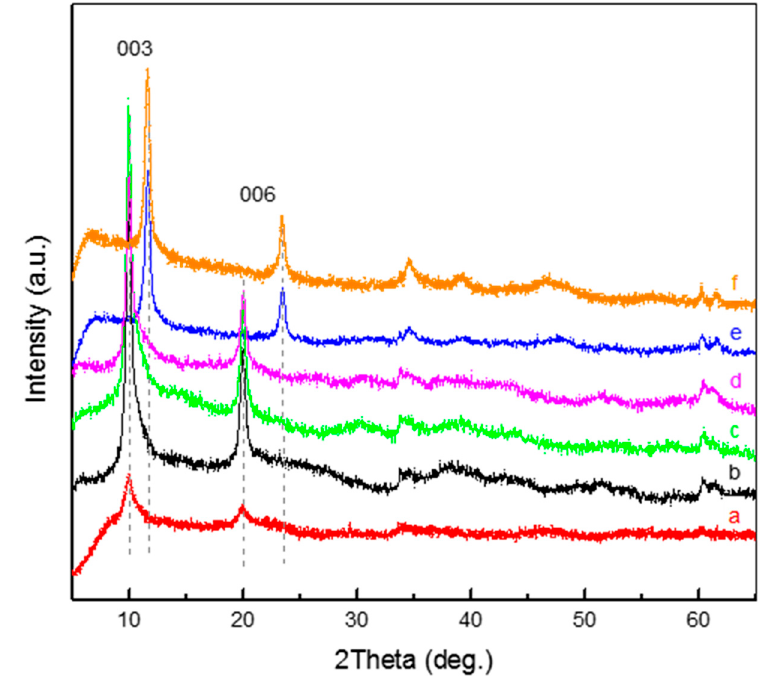
Figure 3. XRD patterns of the Co 2 Al–NO 3 LDH prepared using the conventional co-precipitation method before ( a ), after the NO 3 − → CO 32 − anion-exchange reaction at room temperature either without sonication for 7 min ( b ), 60 min ( c ), 24 h ( d ) and 7 days ( f ) or under a 1.5 kW sonication for 7 min ( e ).